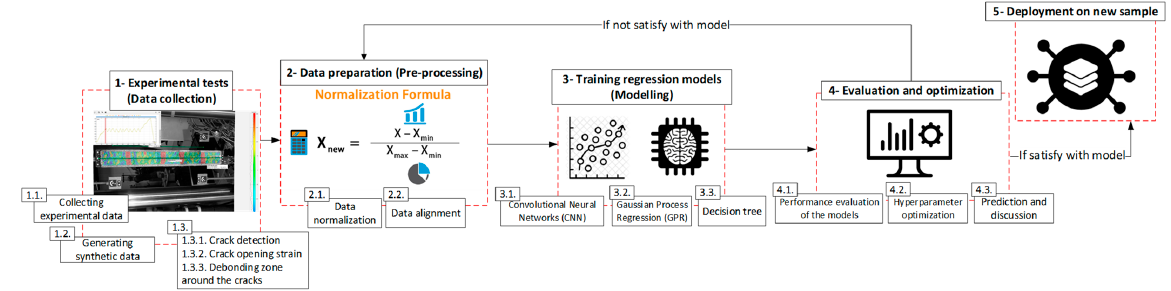
Figure 1. The schematic work fl ow of the proposed hybrid learning approach.